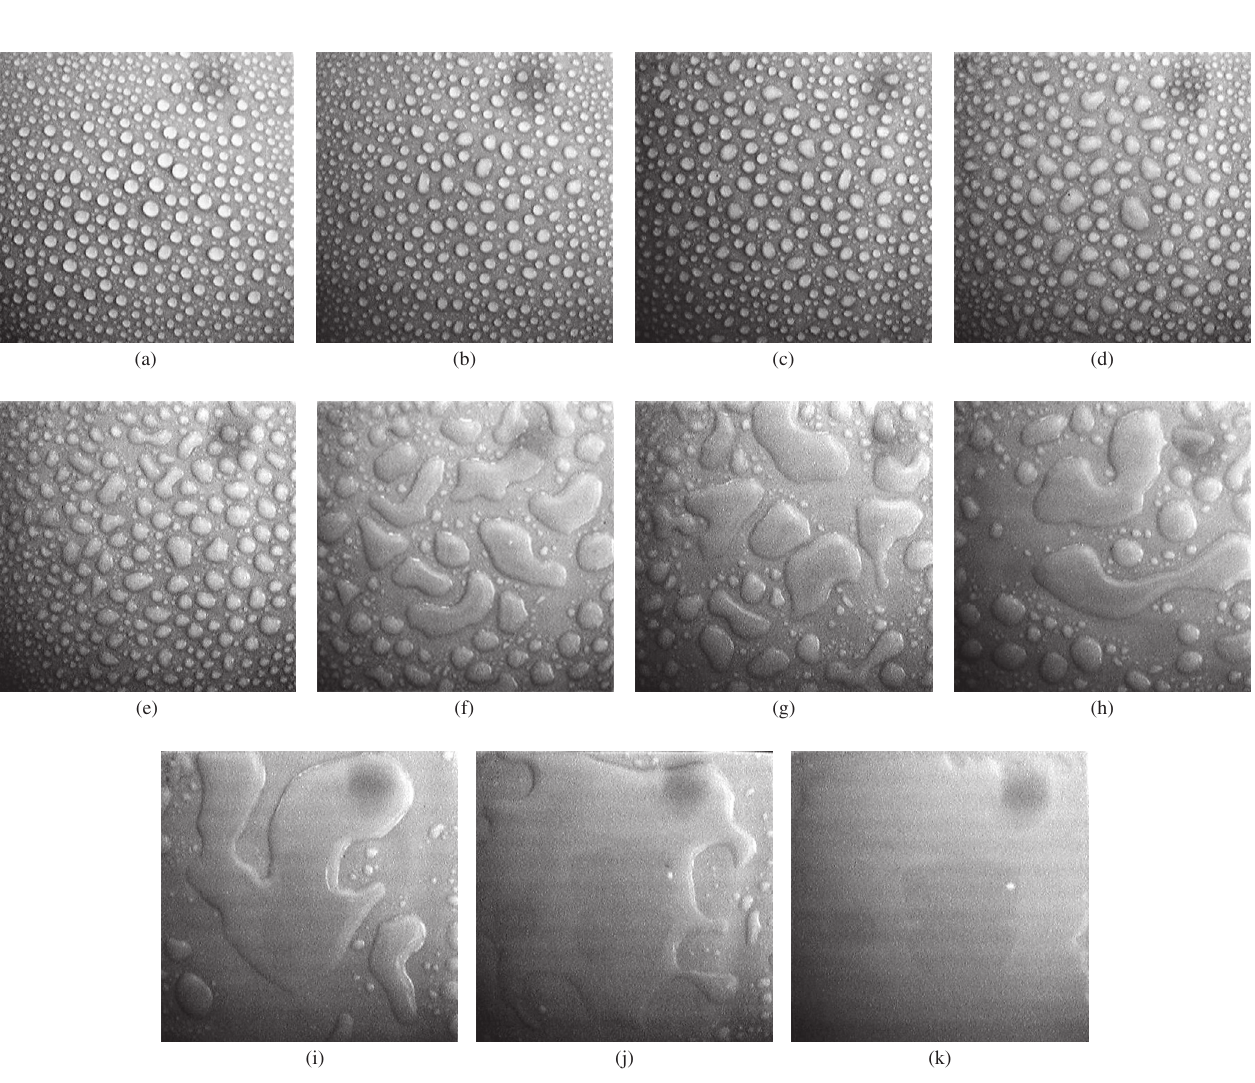
Figure 1. Original images from surfaces sprayed with solutions of a) 0 to k) 100 %AIA